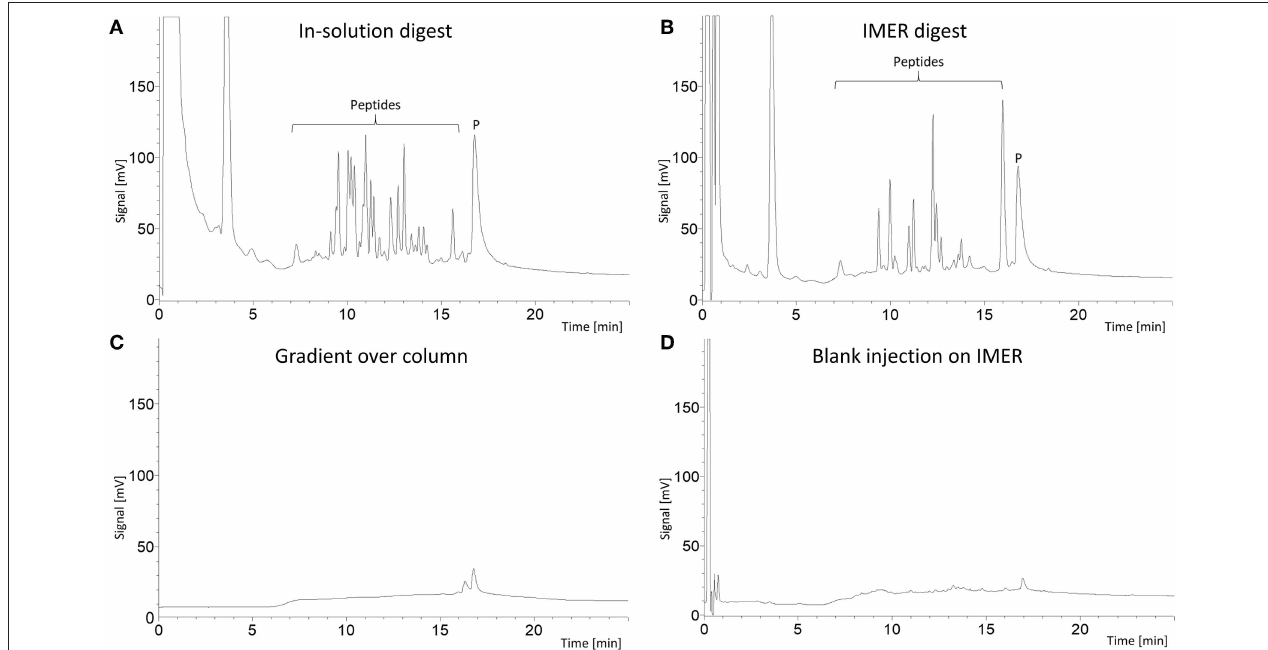
FIGURE 2 | LC-UV chromatograms (210nm) of: (A) 1.4 µ L 500 µ g/mL myoglobin (reduced and alkylated by DTT and IAM) in-solution digest (trypsin:protein, 1:50) injected into a 180 µ m × 110mm poly(VDM-co-EDMA) monolithic support. (B) 1.4 µ L 500 µ g/mL myoglobin (reduced and alkylated by DTT and IAM) injected into